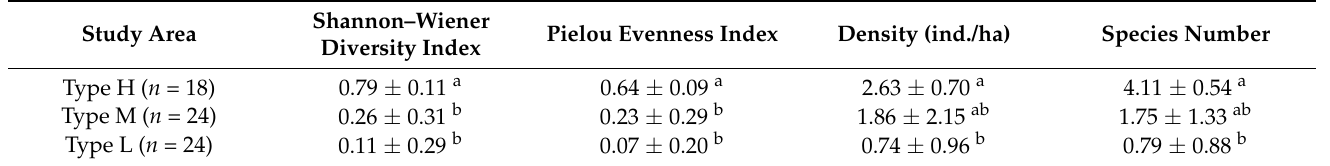
Table 3. Characteristics of shorebird communities in different study areas.